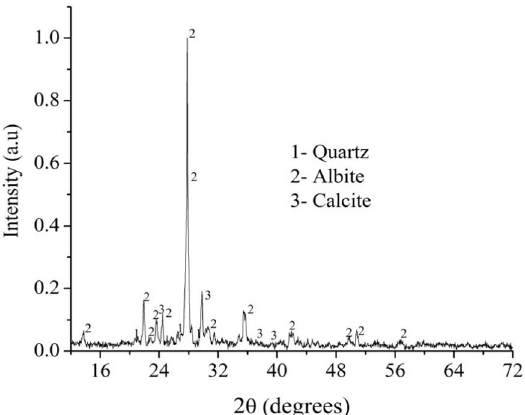
Figure 3 . Diffractogram of the crusher residue used in the production of mortars.